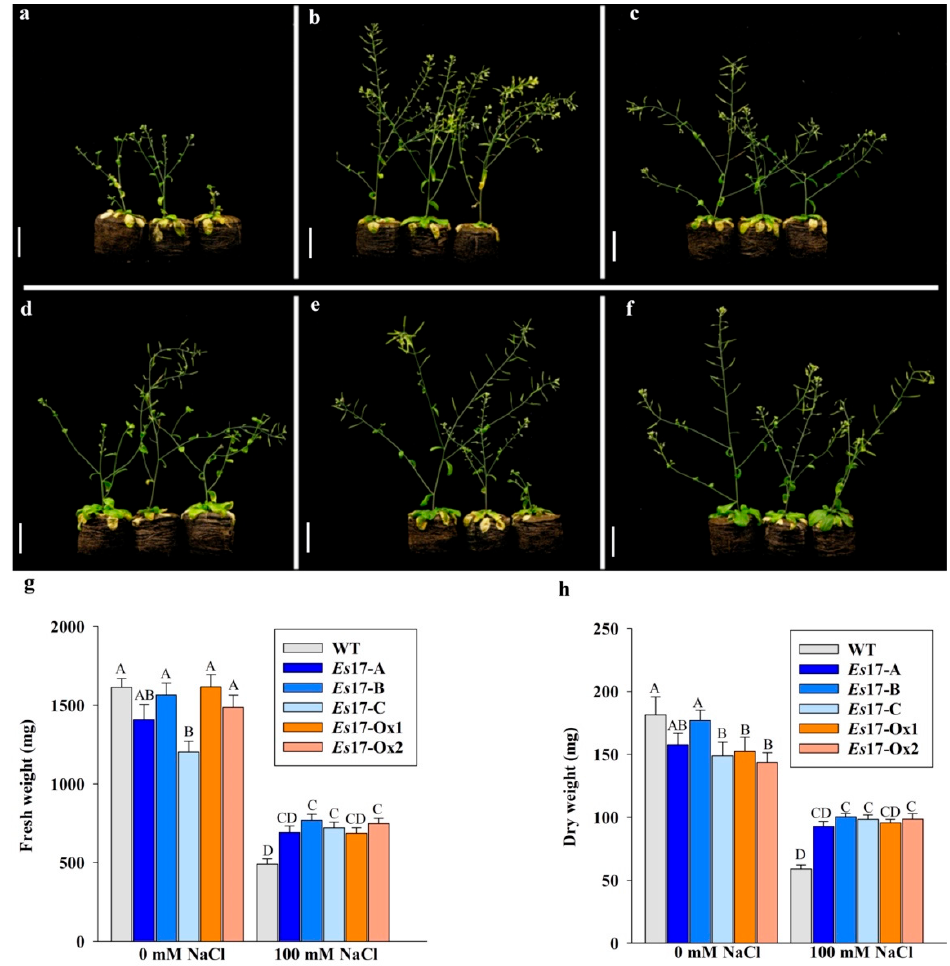
Figure 4. Growth of wild type and 2 independent 35S promoter ( Es 17Ox-1-2,) and of 3 independent stress inducible promoter ( Es 17A-C) transgenic A. thaliana plants, expressing Esi0017_0056 , in presence of 100 mM NaCl concentration maintained throughout the experiment. ( a ) WT, ( b ) Es 17-A, ( c ) Es 17-B, ( d ) Es 17-C, ( e ) Es 17-Ox1, ( f ) Es 17-Ox2, ( g ) fresh weight and ( h ) dry weight. The plants were photographed at 20 days after irrigation. Values represent mean and standard error ( n = 15). Means and SE followed by the same letter are not significantly